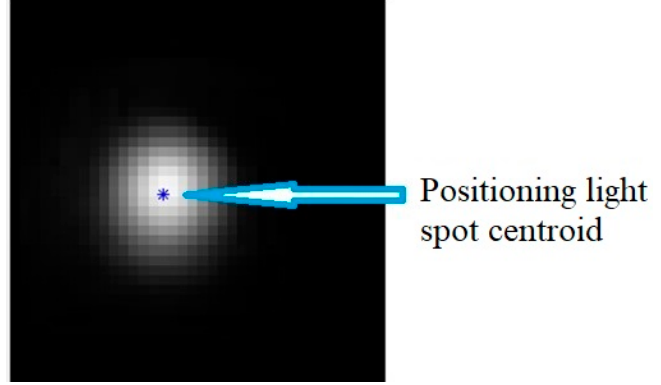
Figure 7. Positioning light spot centroid.